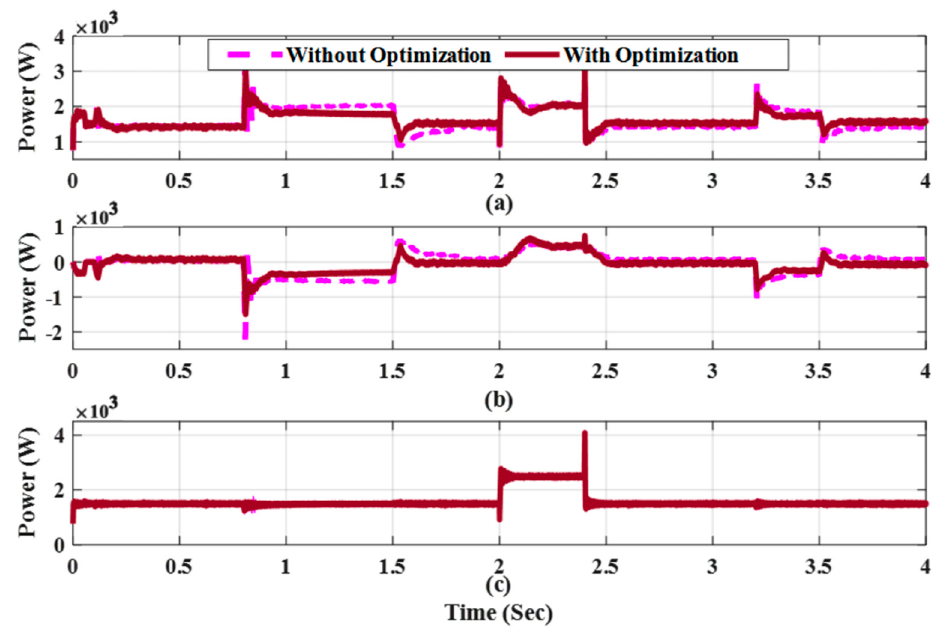
Figure 15. Results of the AC side of the hybrid microgrid: ( a ) AC generator output power ( b ) Inverter power at the point of common coupling ( c ) Load